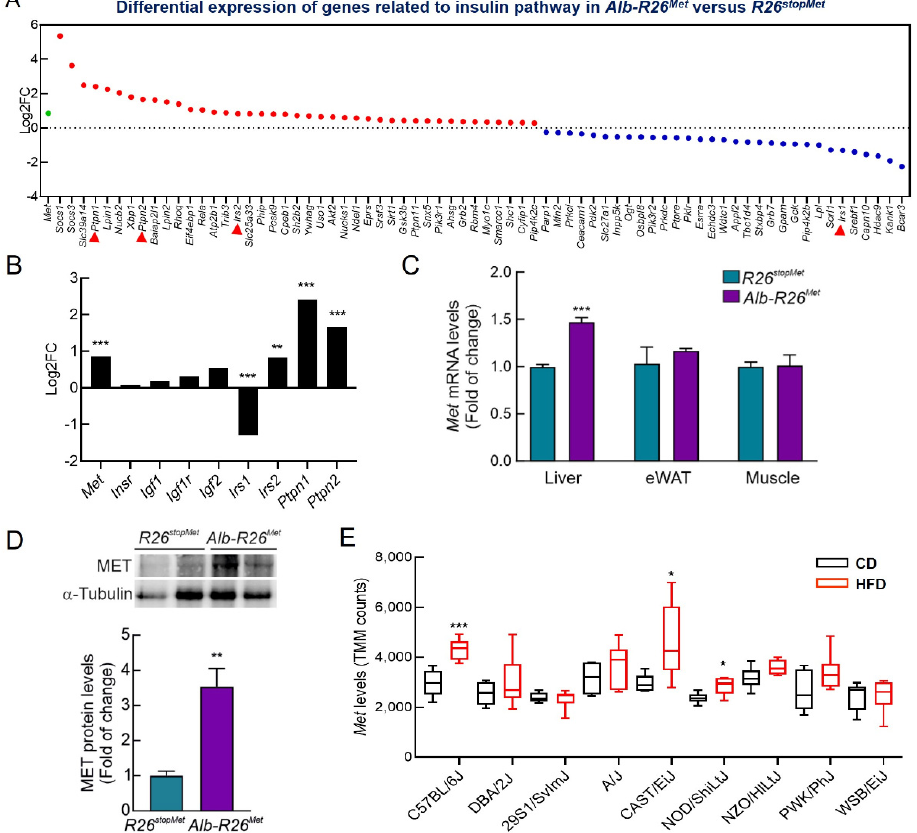
Figure 1. A slight increase in Met levels perturbs the expression of a set of genes related to insulin signaling. ( A ) Dotplot reporting the genes related to insulin signaling pathway that are upregulated (red) or downregulated (blue) resulting from differential expression (DE) analysis and calculated as log2FC of Alb-R26 Met mutant (3 replicates) versus R26 stopMet control livers (4 replicates) analyzed by RNA-seq. Only genes with significant DE are represented ( p < 0.05). Met expression is also included (green). ( B ) Histogram showing log2FC of Met , different ligands ( Igf1 and Igf2 ), mediators ( Ptpn1 , Ptpn2 , Irs1 , and Irs2 ) and receptors ( Insr and Igf1r ) related to the insulin pathway in Alb-R26 Met mutant versus R26 stopMet control livers. ( C ) Met mRNA levels determined by qRT-PCR in liver, epididymal white adipose tissue (eWAT), and skeletal muscle from in R26 stopMet and Alb-R26 Met males ( n = 3 and 6 mice per group, respectively). Tbp mRNA levels were used as endogenous control. ( D ) MET protein levels determined by Western blot in liver in R26 stopMet and Alb-R26 Met mice ( n = 4 and 3 mice per group, respectively). α -Tubulin was used as loading control. Densitometric quantification of MET protein levels. ( E ) Boxplot reporting Met levels, expressed as TMM counts, resulting from the RNA-seq analysis deposited in the available GSE182668 GEO database. Male mice from 9 different strains were fed with either chow diet (CD, black) or high fat diet (HFD, red), n = 6 mice per group. Statistical analysis was performed according to Student’s t test (* p < 0.05, ** p < 0.01, *** p < 0.001).